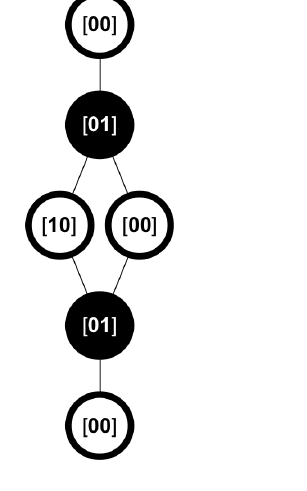
Figure 18 . Adinkra Diagram for 5D (1 , 0)